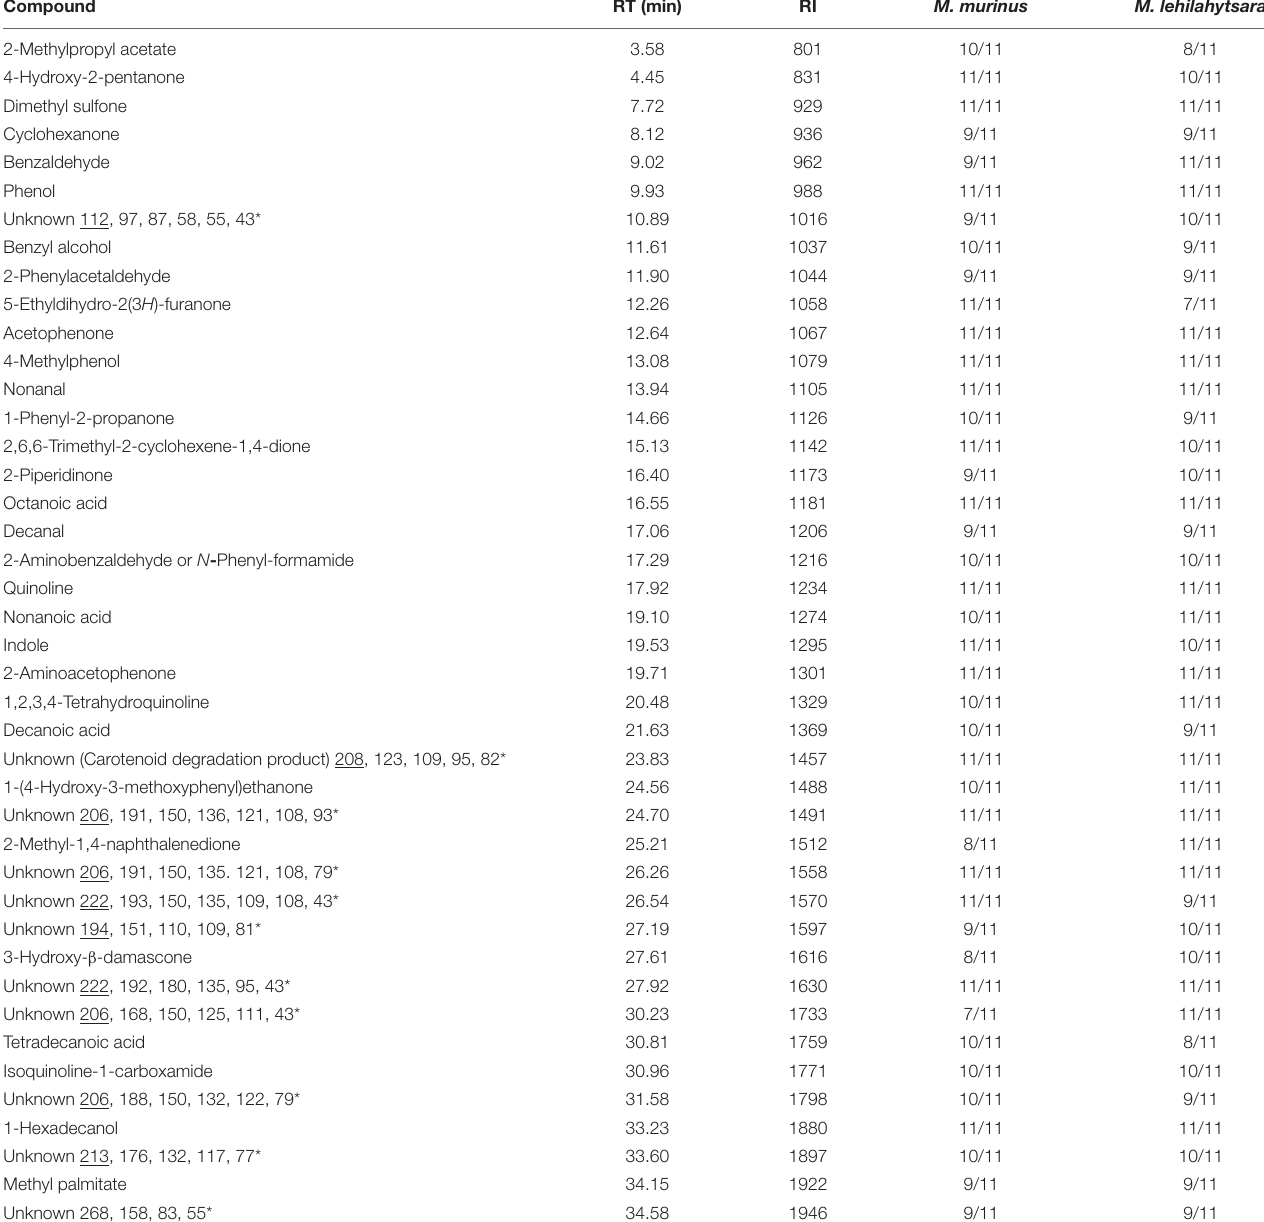
TABLE 1 | Compounds which occurred most frequently in all urine extracts.